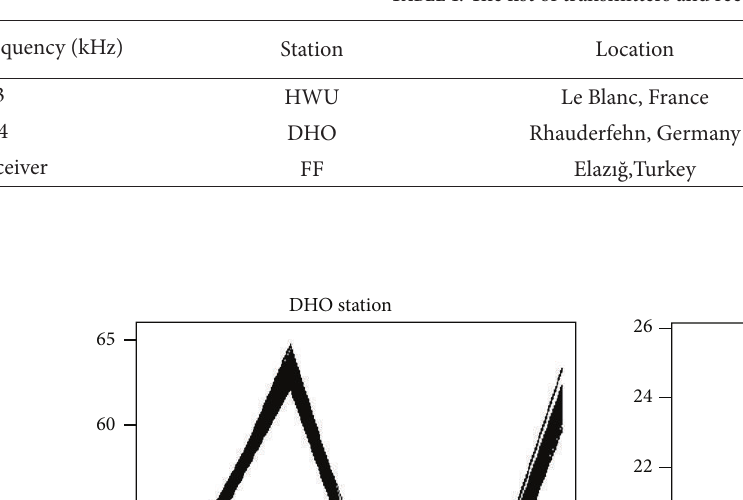
Table 1: The list of transmitters and receiver.